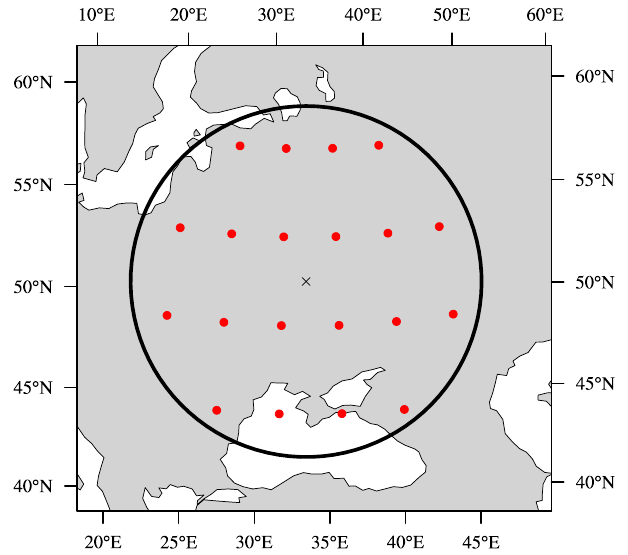
Figure 3. The neighbor grids of the parcel schema. The black cross is the parcel centroid, and the black circle represents the parcel shape that is determined by the deformation matrix. The red filled circles are the neighbor grids connected with the